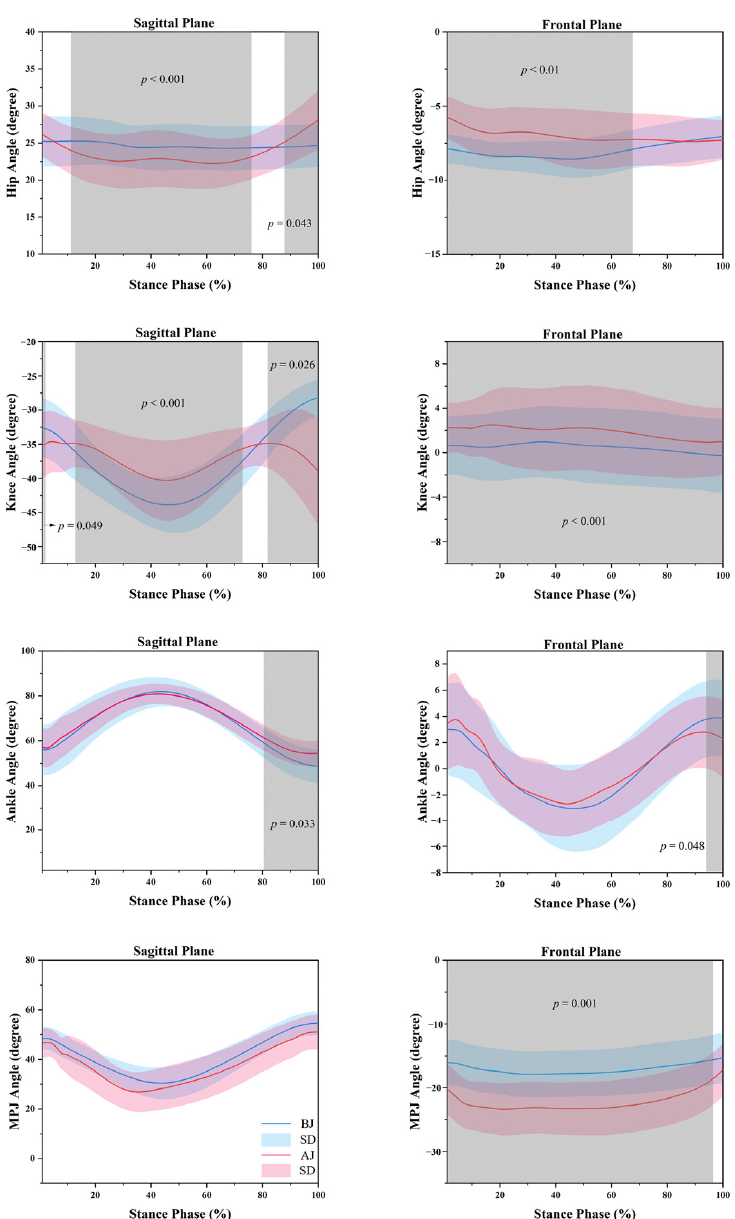
Figure 3. The statistical parametric mapping (SPM) results between bounced jump (BJ) and alternate jump (AJ) tasks following a spike, depicting the mean angle and standard deviation (SD) of the ankle, knee, hip and metatarsophalangeal joint sagittal and frontal plane. Grey shaded areas indicate significant differences between BJ and AJ during the ground-contact phase ( p < 0.05).